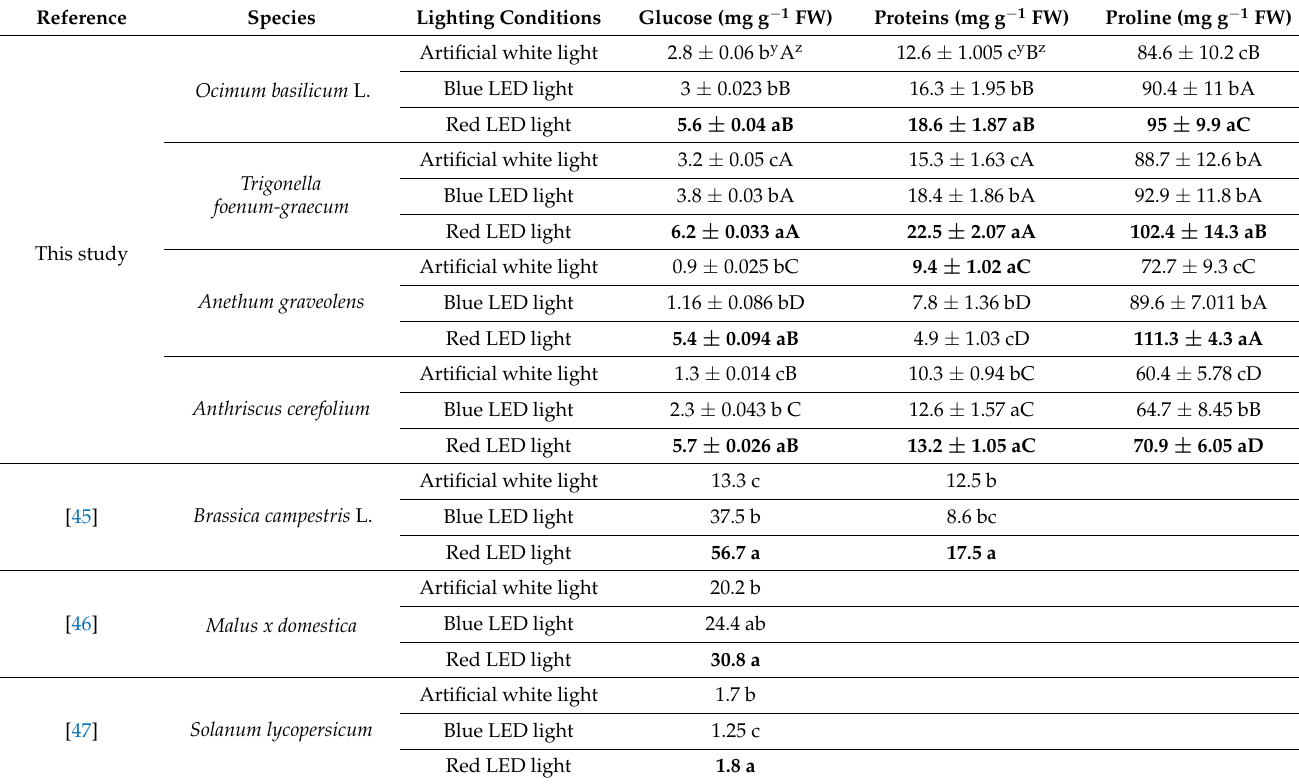
Table 7. The increasing values of glucose, proline, and protein contents using white light, red light, and blue light in previous studies. The best light treatment, for each plant species, is